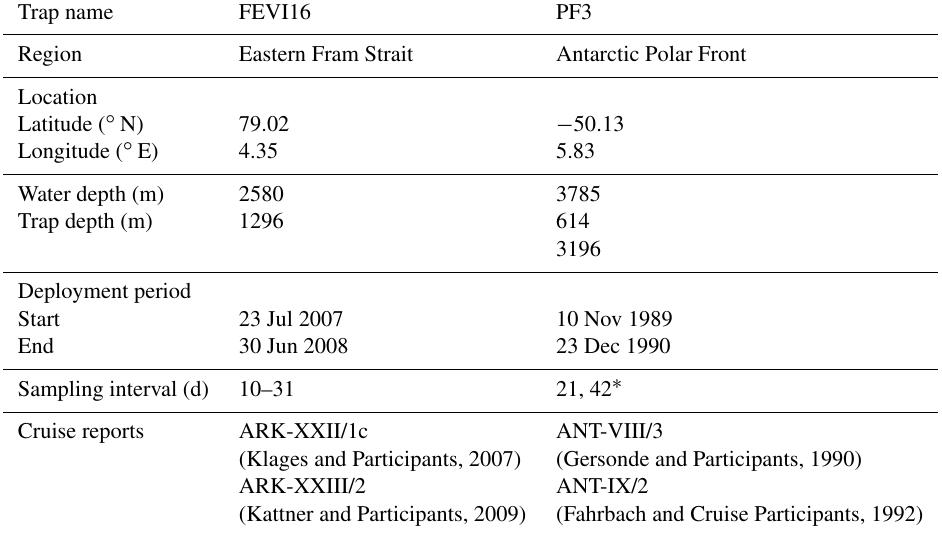
Table 1. Information on FEVI16 and PF3